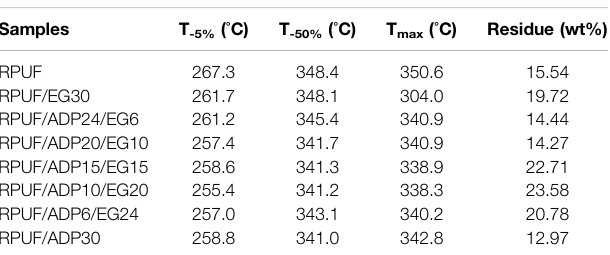
TABLE 4 | LOI and UL-94 test results of RPUF and FR-RPUF composites.